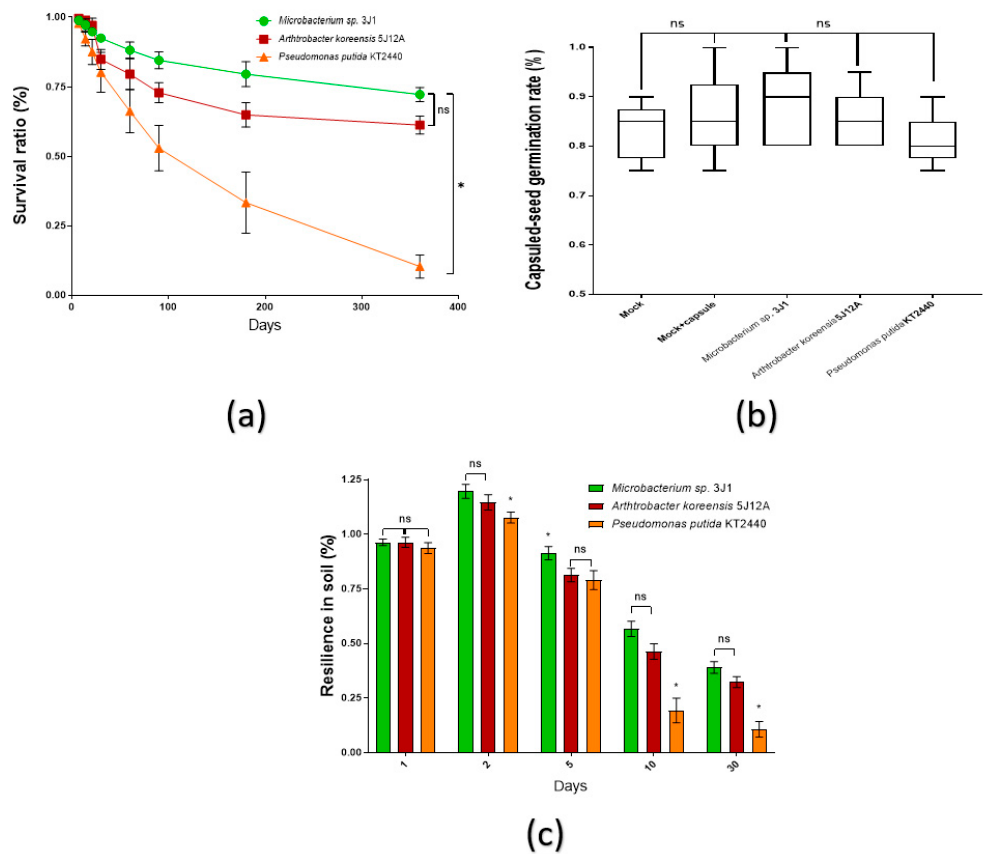
Figure 1. Quality control in dry capsule bioformulation. ( a ) The strains’ survival ratio in this formulation is showed along a year of room temperature stock. The line graph shows data from three independent experiments ( n = 9 biologically independent samples); ( b ) percentage of maize seeds germination was recorded for a week to evaluate possible interference of the bioformulation. The boxplots show representative data from three independent experiments ( n = 60). Whiskers represent the minimum to maximum data range, and the median is represented by the central horizontal line. The upper and lower limits of the box outline represent the first and third quartiles; ( c ) finally, during 30 days, percentage of strains’ resilience in soil was recorded. The bar graph shows data from three independent experiments ( n = 9 biologically independent samples). In these panels, sets of data were compared by two-tailed Student’s t -test and 95% confidence intervals. Error bars represent s.d.; significance of statistical difference: *, significance by p < 0.05; ns, not